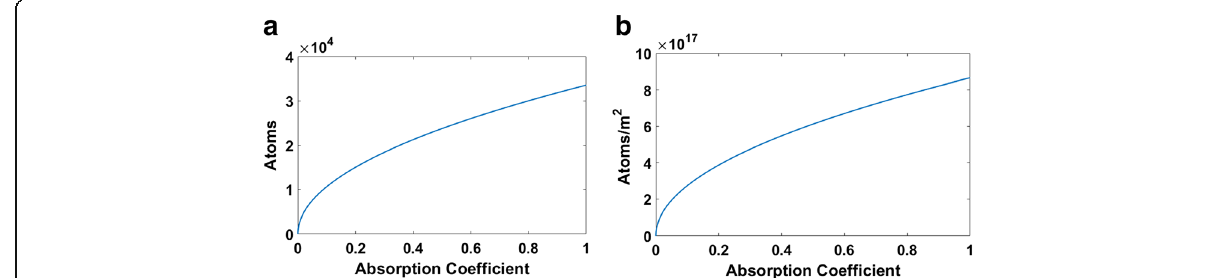
Fig. 7 Theoretical number of evaporated atoms by single and successive pulses at varying absorption coefficients. a number of Evaporated Atoms by Successive Pulses; b number of Evaporated Atoms by Pulse Ablation